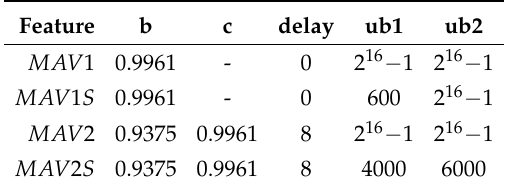
Table 5. Parameters of MAV implementations.